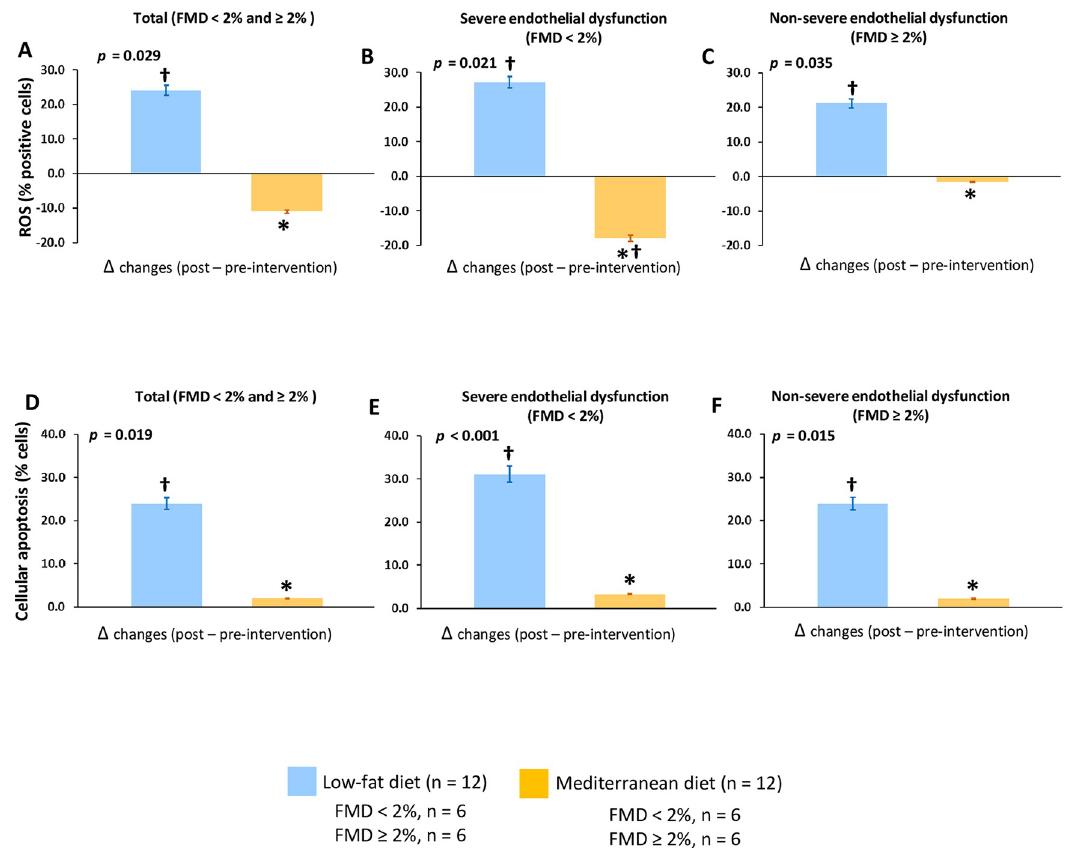
Fig 4. Effect of dietary intervention on in vitro intracellular ROS production and cellular apoptosis. (A, B, and C) Intracellular ROS production in total patients and classified according severity of endothelial dysfunction, respectively. (D, E, and F) Cellular apoptosis in total patients and classified according severity of endothelial dysfunction, respectively. All in vitro experiments were performed in HUVECs incubated with serum samples from 24 selected CHD patients. FMD < 2%, patients with severe endothelial dysfunction; FMD � 2%, patients with nonsevere endothelial dysfunction. Data are presented as Δ changes produced between post- and preintervention ± SE. Variables were compared using the analysis of variance (univariate ANOVA). � Significant changes between Mediterranean diet and low-fat diet ( p < 0.05). †Significant changes between post- and preintervention in each diet ( p < 0.05). CHD, coronary heart disease; FMD, flow-mediated dilation; HUVEC, human umbilical vein endothelial cell; ROS, reactive oxygen species.